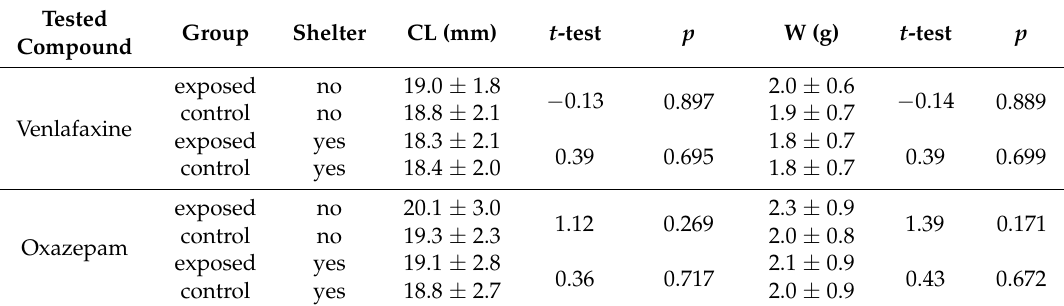
Table 1. The mean carapace length (CL) and weight (W) of marbled crayfish ( Procambarus virginalis , Lyko 2017) animals used in the experimental groups in either the presence or absence of shelter. Data are presented as mean ± standard deviation. The t -test values and p -values are shown to demonstrate no differences between experimental